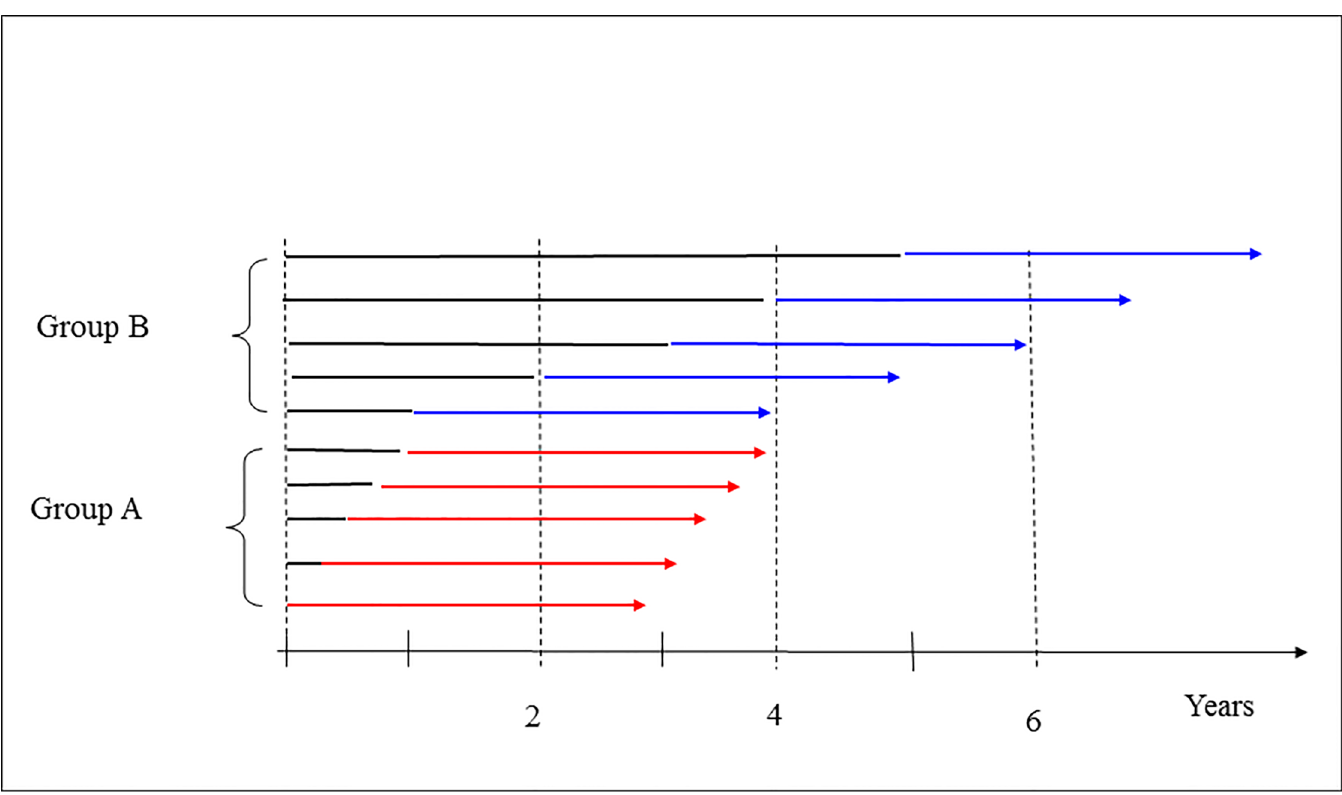
Fig 2. Women who have used CHT in 3 to 4 years are referred to as Group A; women who have used CHT in 4 to 9 years are referred to as group B. The arrows indicate the individual follow-up periods from first starting using CHT. In a randomized trial women are followed from time zero to the end of the arrows. In the observational studies women are only followed in the red and blue coloured part of the arrows. If the breast incidence is time-varying, then this will lead to systematic shift of diagnosis from the black part of the arrows to the coloured part of the arrows because of delay in time of diagnosis. This is leading to an over-estimation of the hazard rates in the period indicated by red and blue colours.